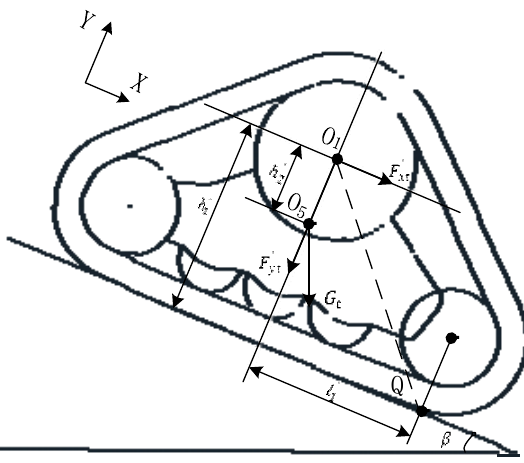
Figure 6. Partial force schematic of the triangular track when climbing up.